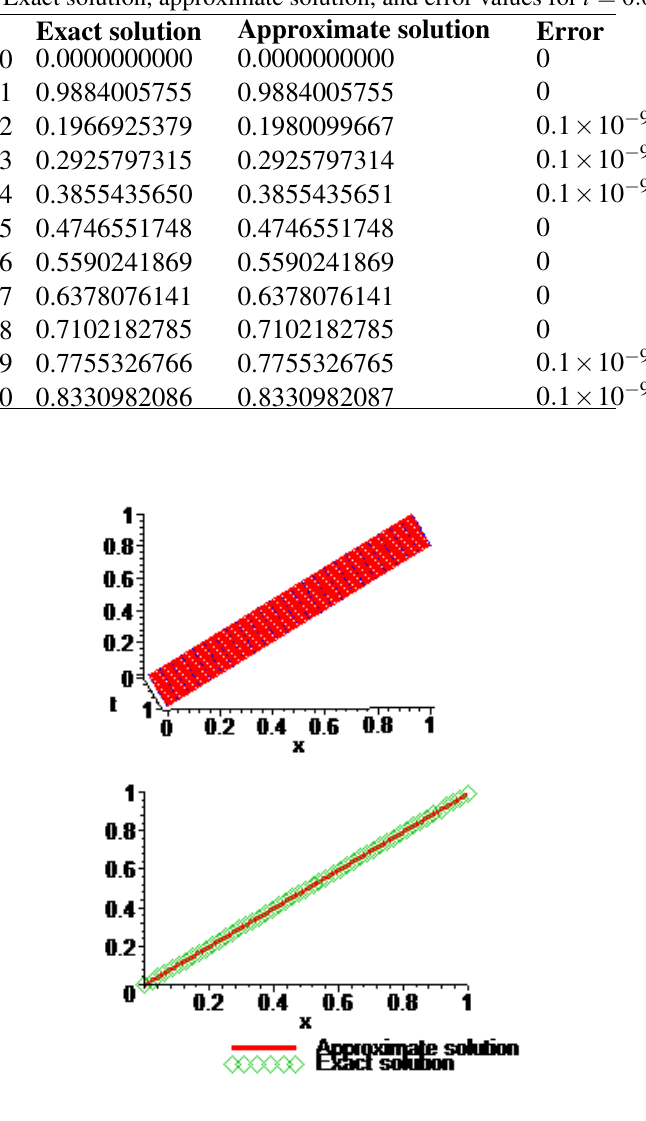
Fig. 2 Comparison of exact and approximate solutions for Example